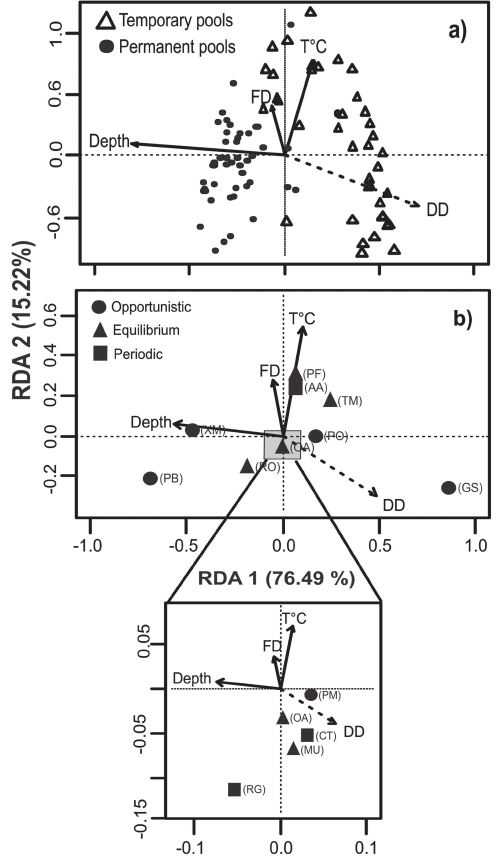
Fig. 4. Redundancy analysis (RDA) biplot of sites scores (a) and species scores (b) for fish species recorded in the Sian Ka’an wetland regarding the life history strategy; lower panel represents a close up from the center of the RDA diagram in order to illustrate tightly grouped species. Arrows point in the direction of maximum variability explained by the respective environmental variable; dashed arrow represents no– significant variables in the RDA model. The fish species names are represented in parentheses: GS = Gambusia sexradiata , PM = Poecilia mexicana , PB = Pseudoxiphophorus bimaculatus , XM = Xiphophorus maculatus , PO = Poecilia orri , TM = Thorichthys meeki , MU = Mayaheros urophthalmus , PF = Parachromis friedrichsthalii , RO = Rocio octofasciata , RG = Rhamdia guatemalensis , CT = Cynodonichthys tenuis , AA = Astyanax aeneus , OA = Ophisternon aenigmaticum